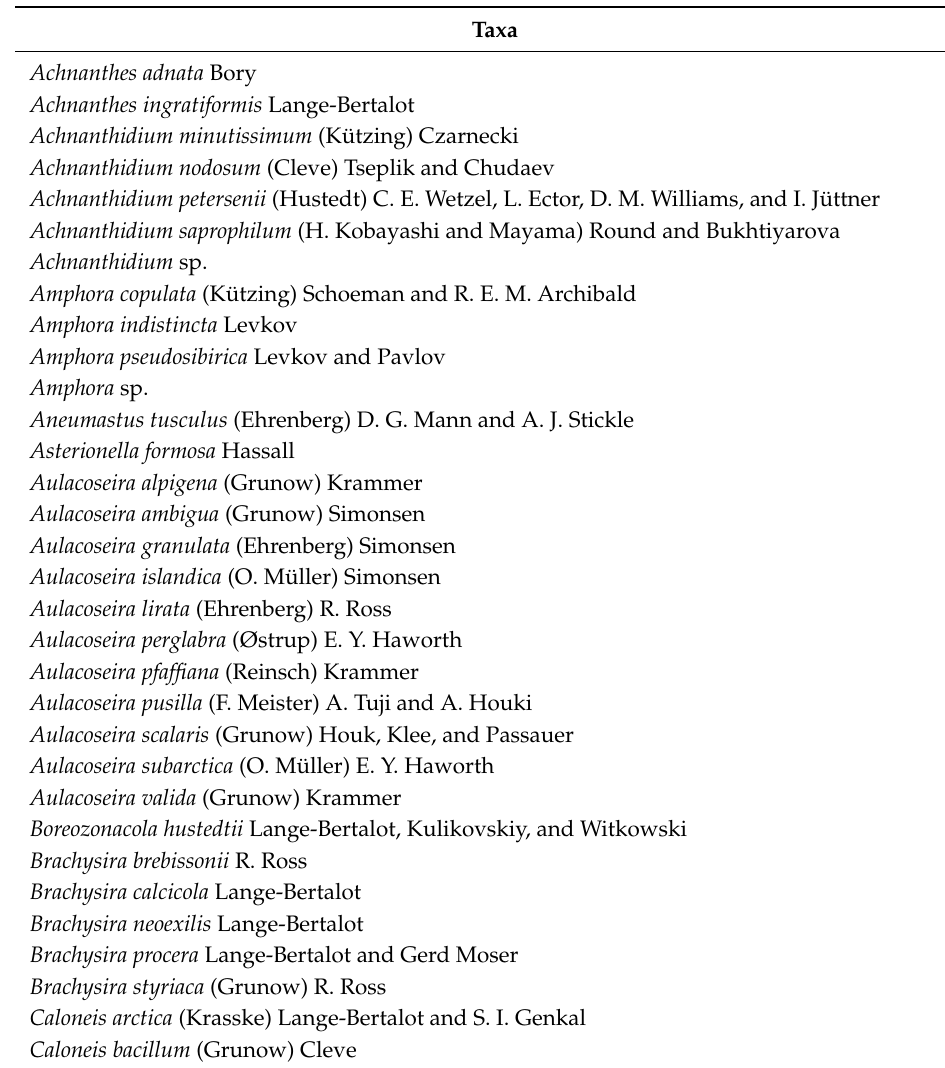
Table A2. Diatom species richness in the 14 studied water bodies in the vicinity of Tiksi Bay, July 2021. “1”—present,